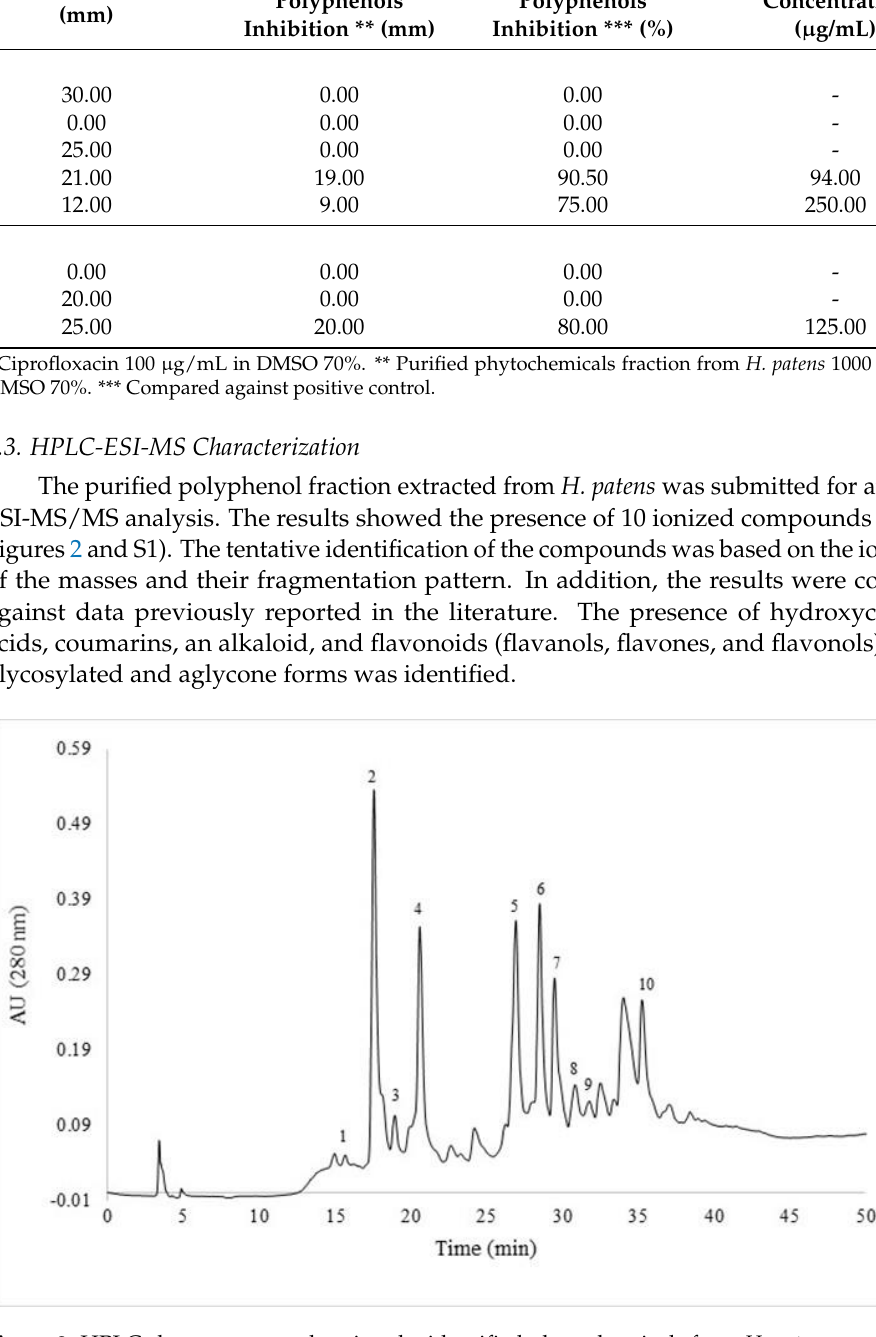
Table 5. Inhibitory effect of purified polyphenol fraction of H. patens against Gram-negative and Gram-positive bacteria.